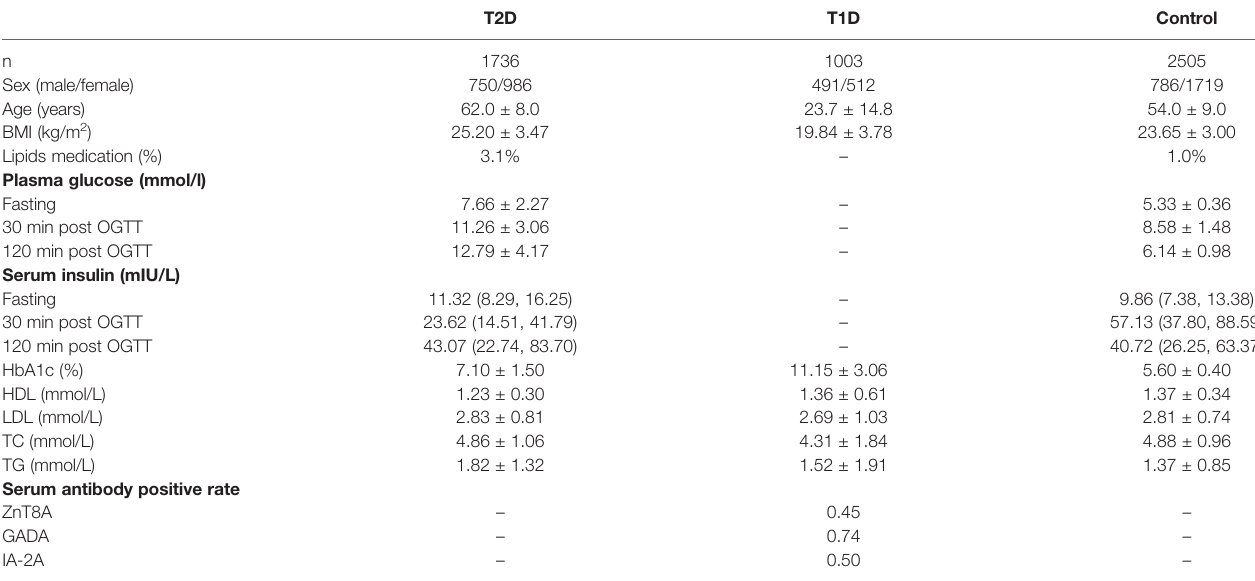
TABLE 1 | Overall study population and metabolic index